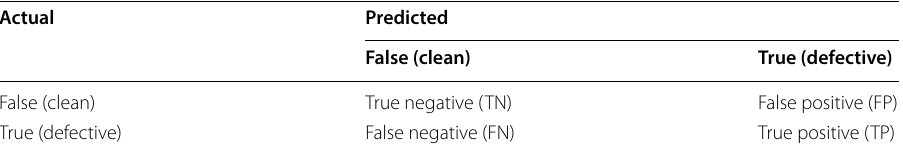
Table 2 Confusion matrix